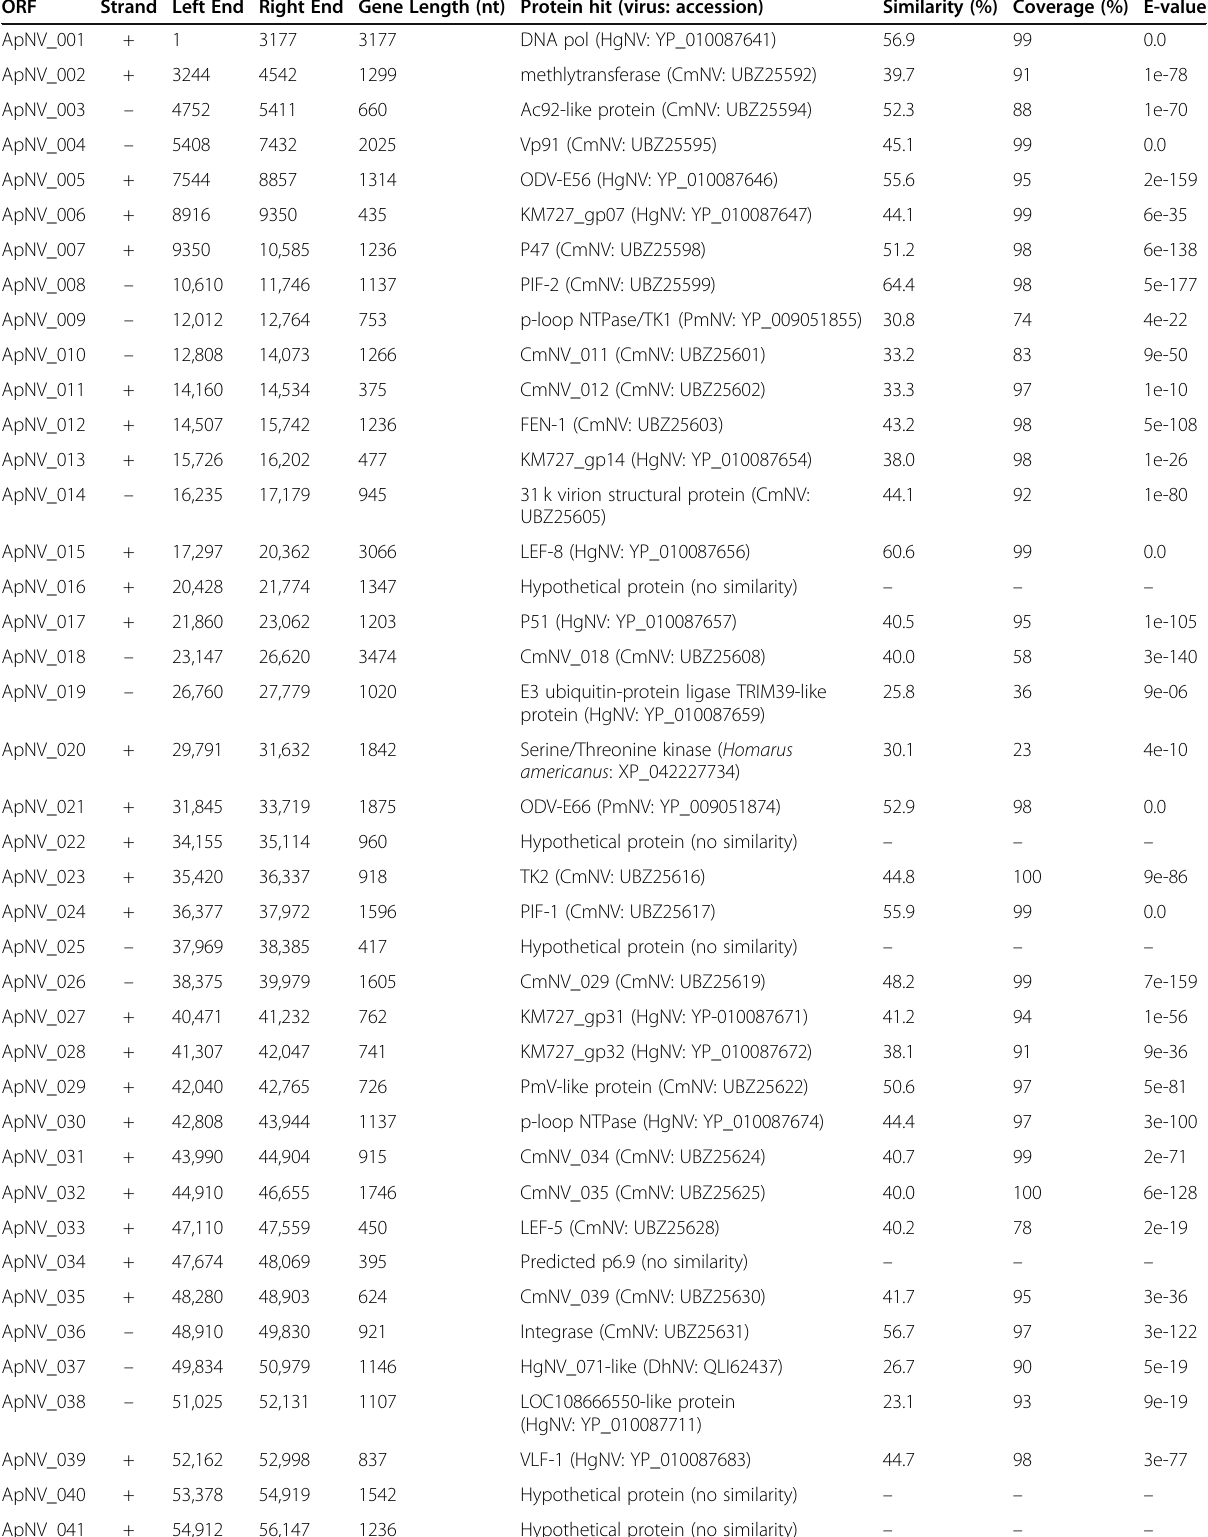
Table 2 ‘ Aratus pisonii nudivirus ’ (ApNV) protein similarity table. Similarity and function/domain are determined using BLASTp ORF Strand Left End Right End Gene Length (nt) Protein hit (virus: